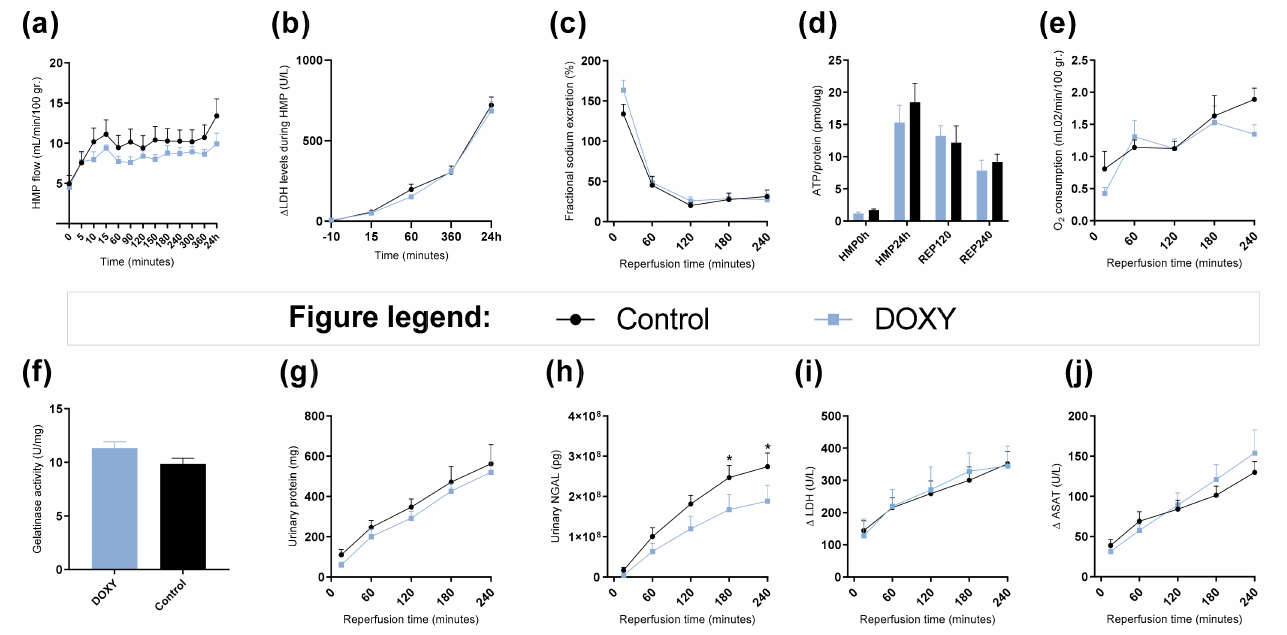
Figure 5. Renal function during hypothermic machine perfusion and ex vivo reperfusion. ( a ) Arterial flow during hypothermic machine perfusion (HMP) shown in mL/min/100 gr. of kidney weight over time. ( b ) LDH levels in perfusate in U/L during HMP. ( c ) Fractional sodium excretion shown in % during reperfusion. ( d ) ATP levels in cortex tissue shown in pmol per ug protein at time point: HMP0h, HMP24h or pre-reperfusion, 120 min into reperfusion and 240 min into reperfusion or post-reperfusion. ( e ) Oxygen consumption shown in mL O 2 /min/100 gr. of kidney weight during reperfusion. ( f ) Gelatinase activity after 240 min of reperfusion. ( g ) Absolute accumulative urinary protein levels in mg. ( h ) Absolute accumulative urinary NGAL levels in pg. ( i ) delta LDH levels in perfusate in U/L during reperfusion. ( j ) delta ASAT levels in perfusate in U/L during reperfusion. * = p < 0.05. Data shown as mean ± SEM. DOXY; doxycycline